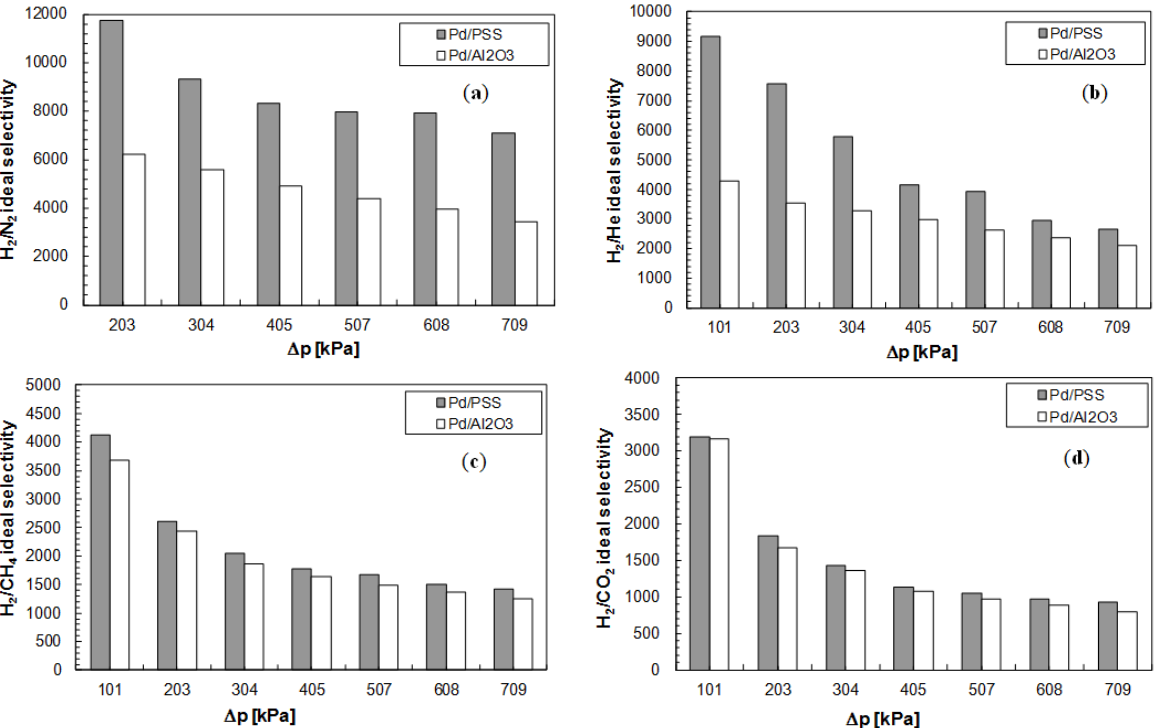
O membranes. ( a ) α 2 3